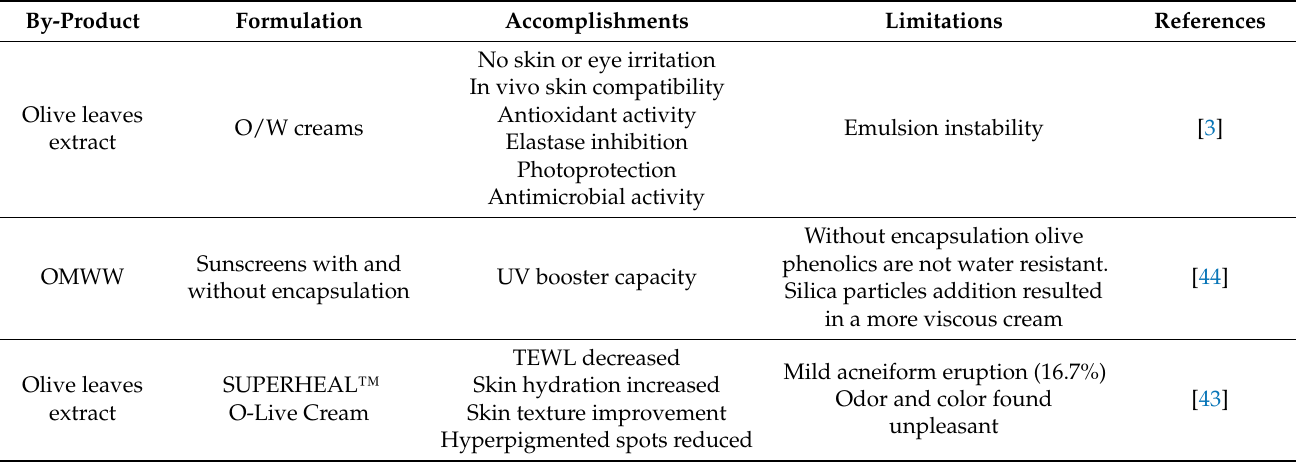
Table 2 reviews the cosmetic applications of olive oil by-products found in the literature. Table 2. Cosmetic application of olive oil